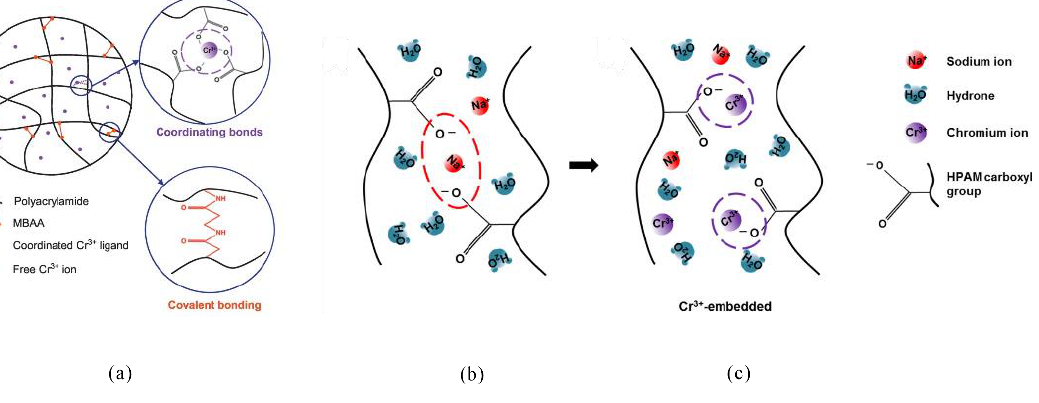
Figure 11. The Schematic diagram of the preparation of salt-insensitive microgels by pre-embedding of Cr 3+ ligands. ( a ) The schematic representation of the Cr 3+ -embedded microgels; ( b , c ) schematic representations of the poly (acrylic acid)-based microgels and the Cr 3+ -embedded microgels influenced by the sodium ions. (Reprinted/adapted with permission from Ref. [70]. 2019, Pu, et al”) .